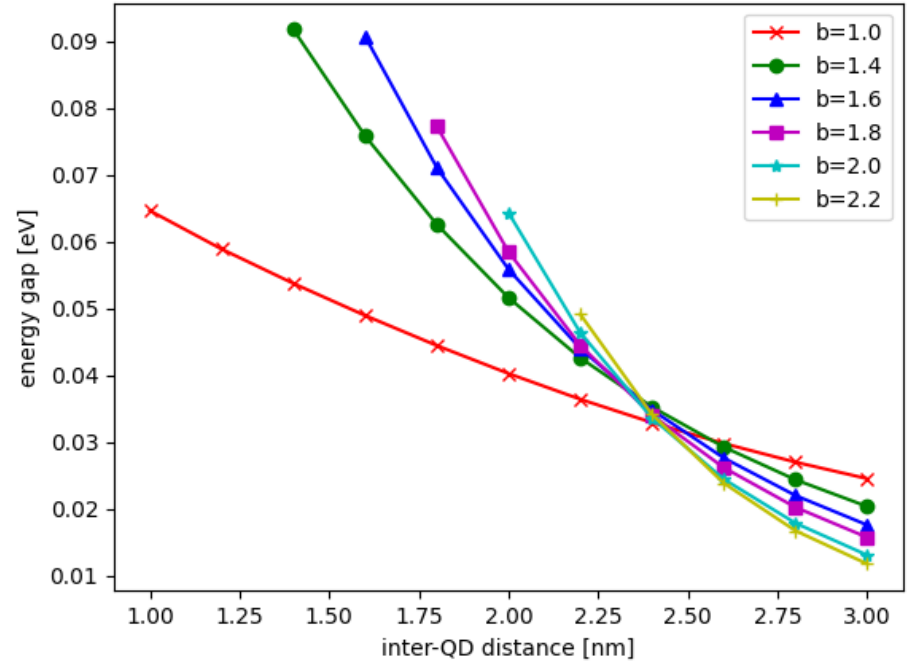
Figure 4. The energy gap ∆ between the bonding and anti-bonding states of electron as a function of the inter-QD distance d , the different lengths of QD base b are shown in different colors and